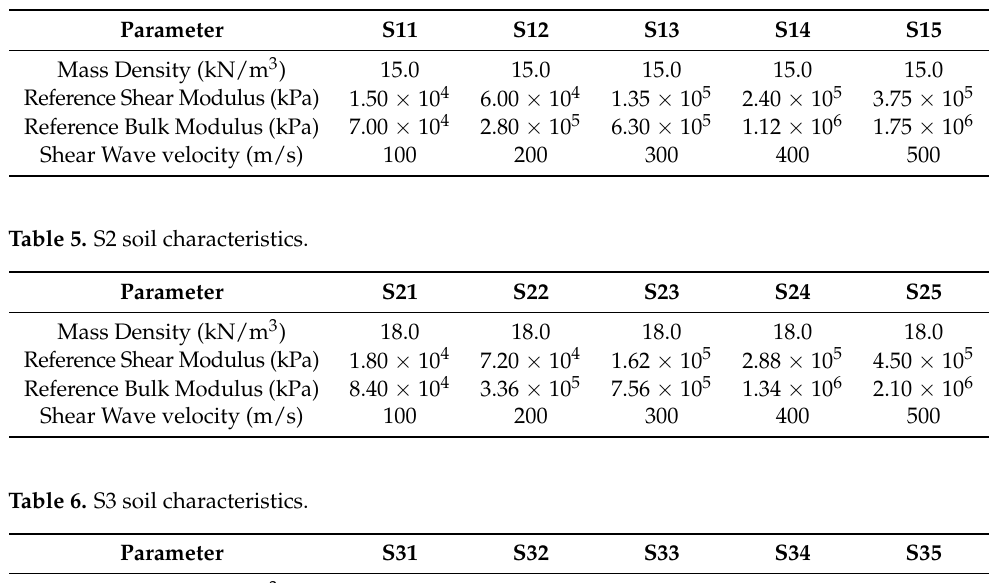
Figure 8. Backbone curve (S3 soil). Table 4. S1 soil characteristics. Table 1. Foundation parameters.